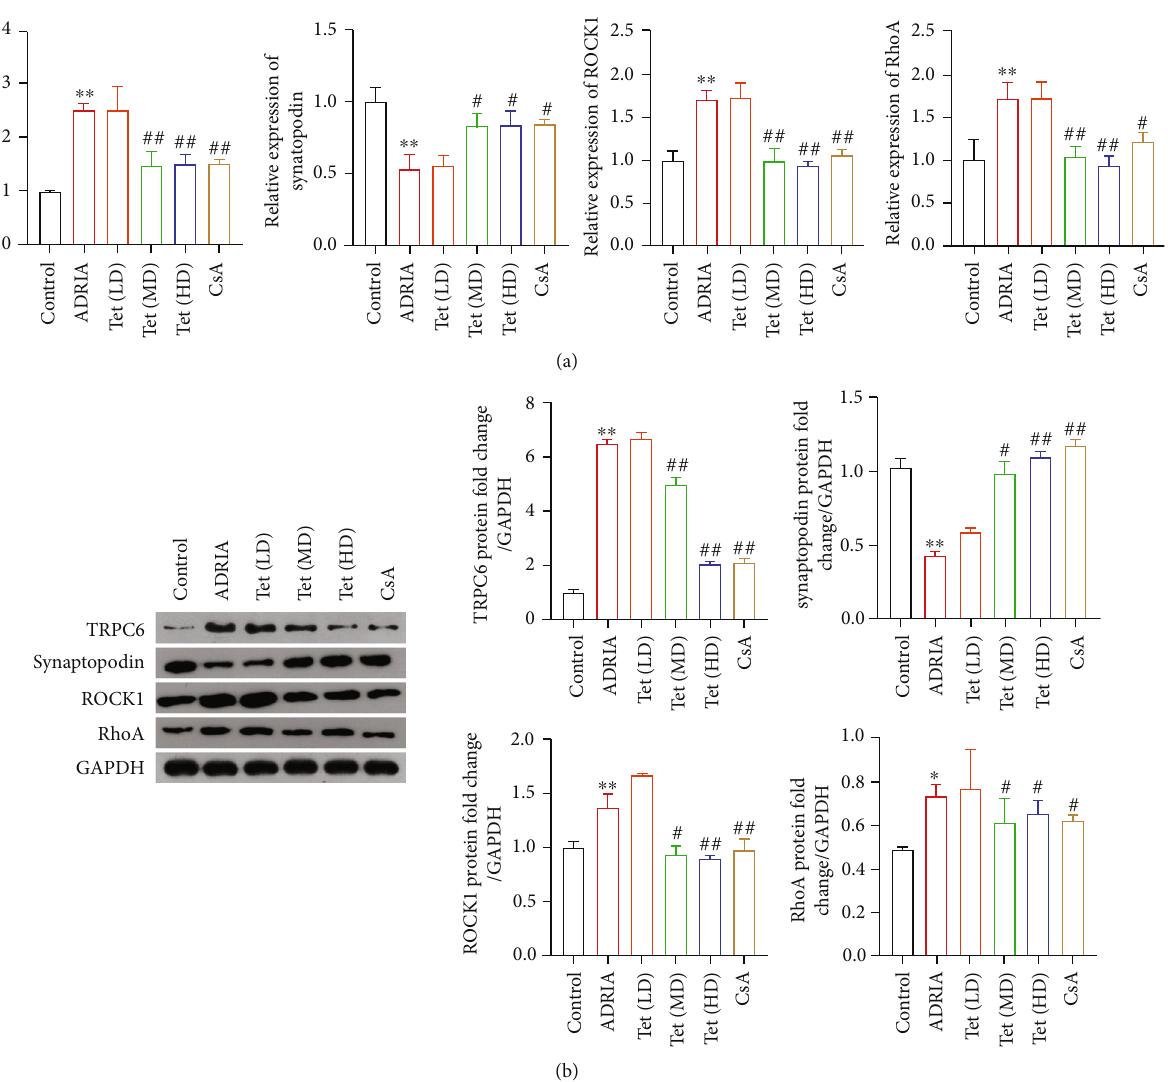
Figure 2: Tetrandrine (Tet) inhibits TRPC6 expression and RhoA/ROCK1 pathway in vivo . (a) The mRNA expression of TRPC6, synaptopodin, RhoA, and ROCK1 in kidney tissues of rats was measured by RT-qPCR. (b) The protein expression of TRPC6, synaptopodin, RhoA, and ROCK1 in kidney tissues of rats was detected by western blotting. Nephropathy rats were induced by adriamycin (ADRIA) and then treated with low-dose (LD), medium-dose (MD), and high-dose (HD) Tet, or cyclosporine A (CsA, a positive drug). ∗ P < 0 : 05 and ∗∗ P < 0 : 01 versus the control group. # P < 0 : 05 and ## P < 0 : 01 versus the ADRIA